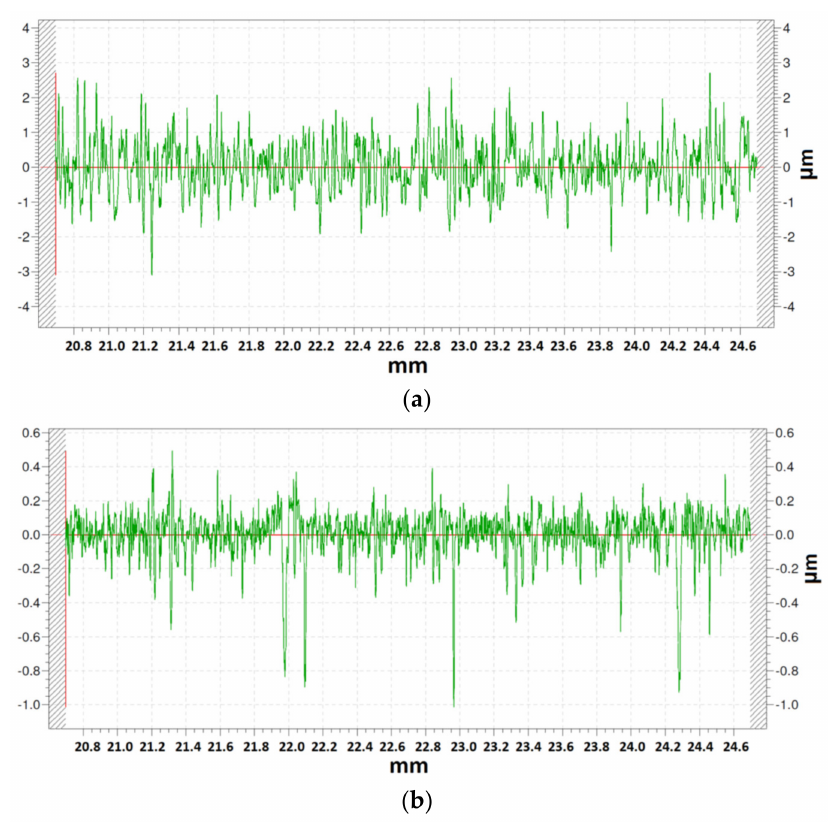
Figure 4. Roughness profiles obtained with: ( a ) grain size 30, ( b ) grain size